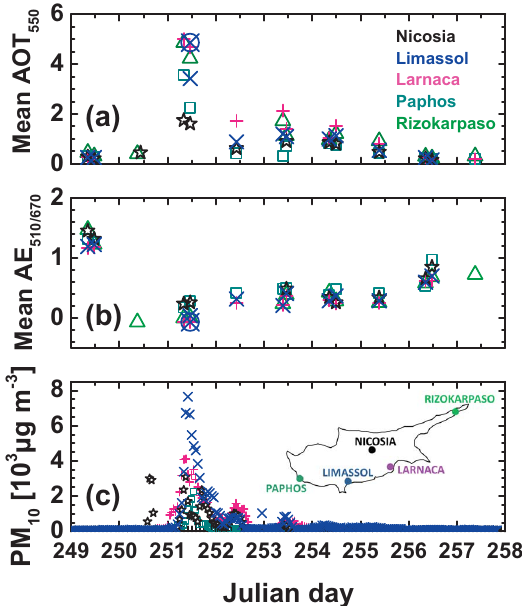
Figure 7. (a) MODIS-derived mean 550nm aerosol optical thick- ness (AOT) for five sites in Cyprus for the period from 6 to 14 September 2015 (Nicosia, stars; Limassol, diagonal crosses; Larnaca, crosses; Paphos, squares; Rizokarpaso, triangles; aqua- MODIS, 10:30–11:30UTC, and terra-MODIS, 08:00–09:00UTC overpasses), (b) MODIS-derived Ångström exponent (for the 510– 670nm wavelength range), and (c) hourly mean PM 10 particle mass concentrations measured at four stations in Cyprus (Nicosia, Limas- sol, Paphos, Larnaca). The AOTs are determined from all MODIS values in areas within a 50km radius around a given city, except the AOT indicated by the blue diagonal cross with a circle (Limassol, 25km radius, day